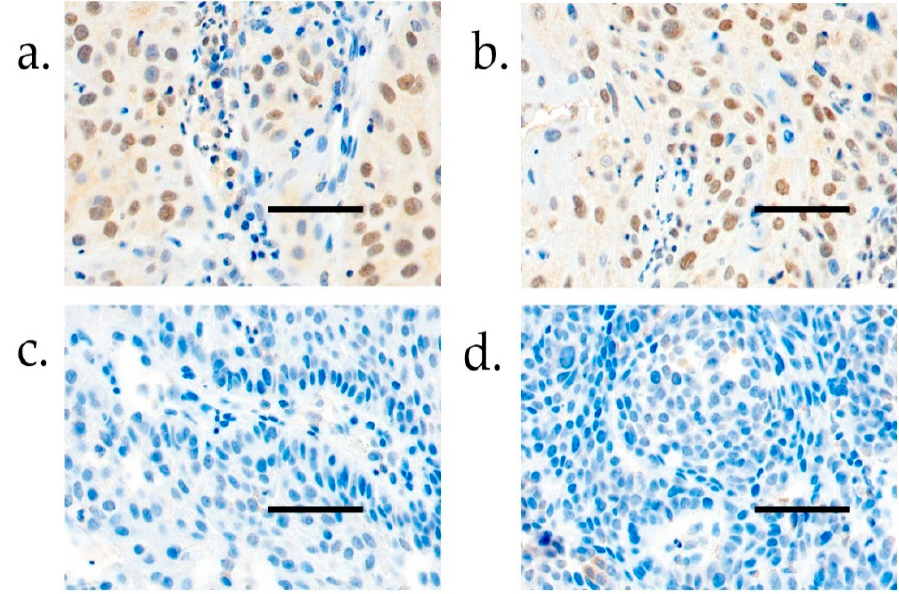
Figure 1. ( a ) Positive hCG β immunoexpression in tumor tissue. ( b ) Positive hCG β immunoexpression in tumor tissue. ( c ) Negative hCG β immunoexpression in tumor tissue. ( d ) Negative hCG β immunoexpression in tumor tissue. Scale bar length, 100 µm. Magnification, ×400.